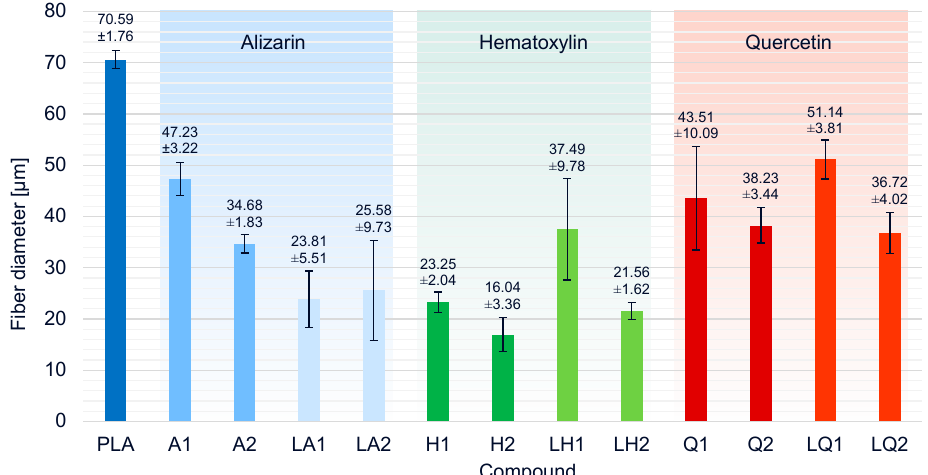
Figure 14. Fiber diameters and standard deviations of PLA and the PLA / dye compounds produced by melt ‐ electrospinning at 275 °C using a single ‐ nozzle laboratory device.